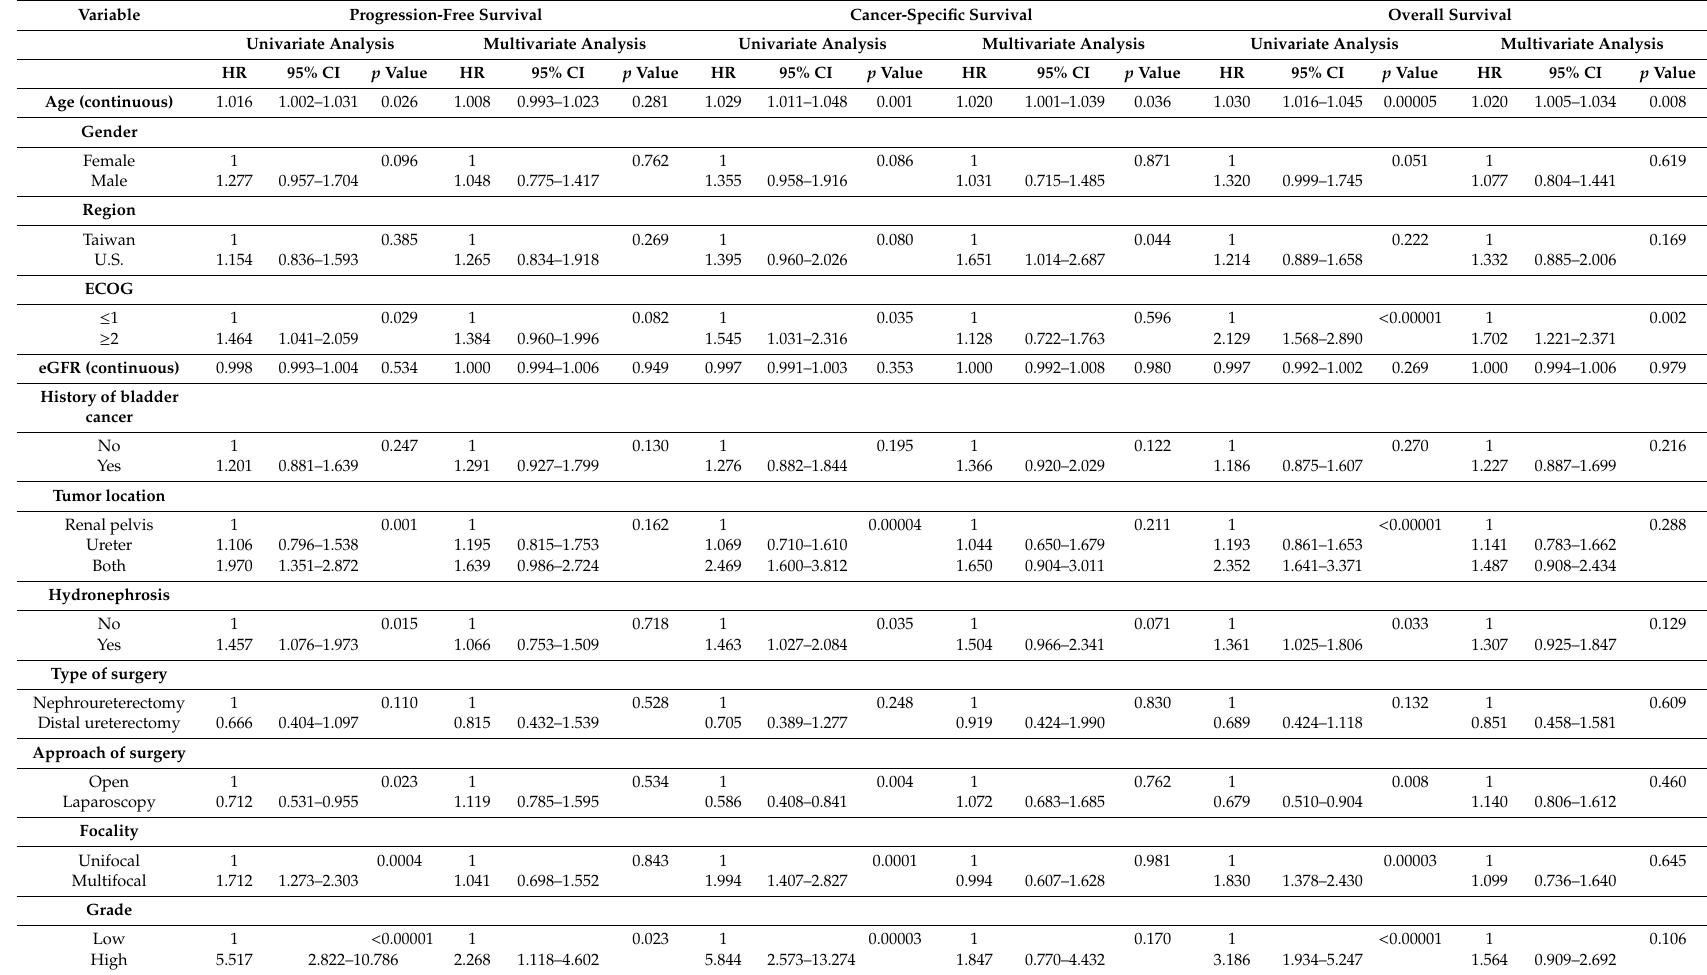
Table 2. Univariate and multivariate analyses of progression-free, cancer-specific, and overall survival in 737 patients with